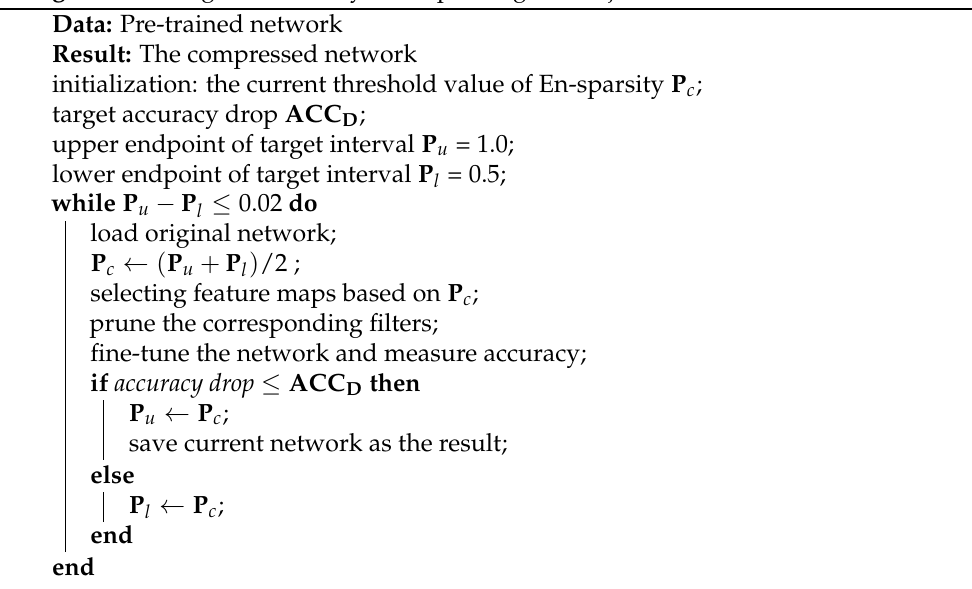
Algorithm 1: Algorithm for dynamic pruning and adjustment of P . Data: Pre-trained